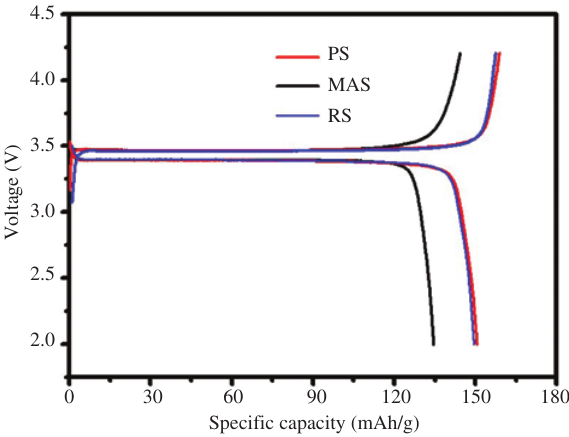
Figure 3: The first charge/discharge cycles for samples at 0.2 C